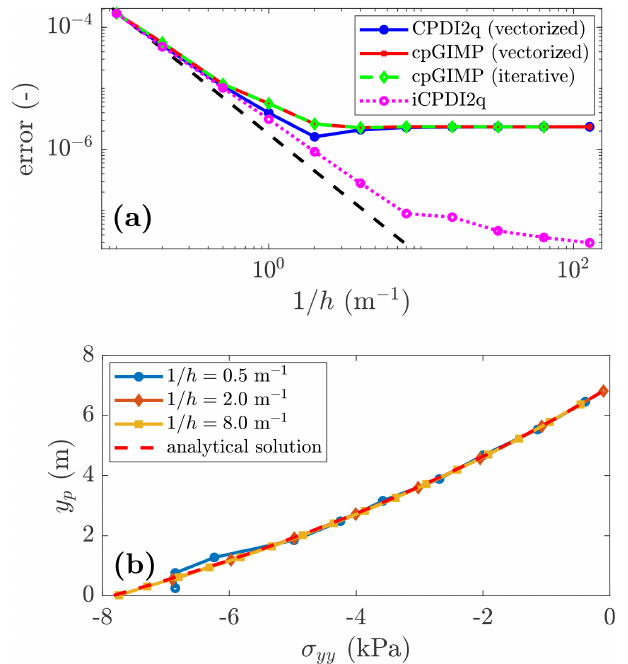
Figure 9. (a) Convergence of the error: a limit is reached at error ≈ 2 × 10 − 6 for the explicit solver, whereas the quasi-static solution still converges. This was demonstrated in Bardenhagen and Kober (2004) as an error saturation due to the explicit scheme, i.e. the equi- librium is never resolved. (b) The stress σ yy along the y axis pre- dicted at the deformed position y p by the CPDI2q variant is in good agreement with the analytical solution for a refined mesh.